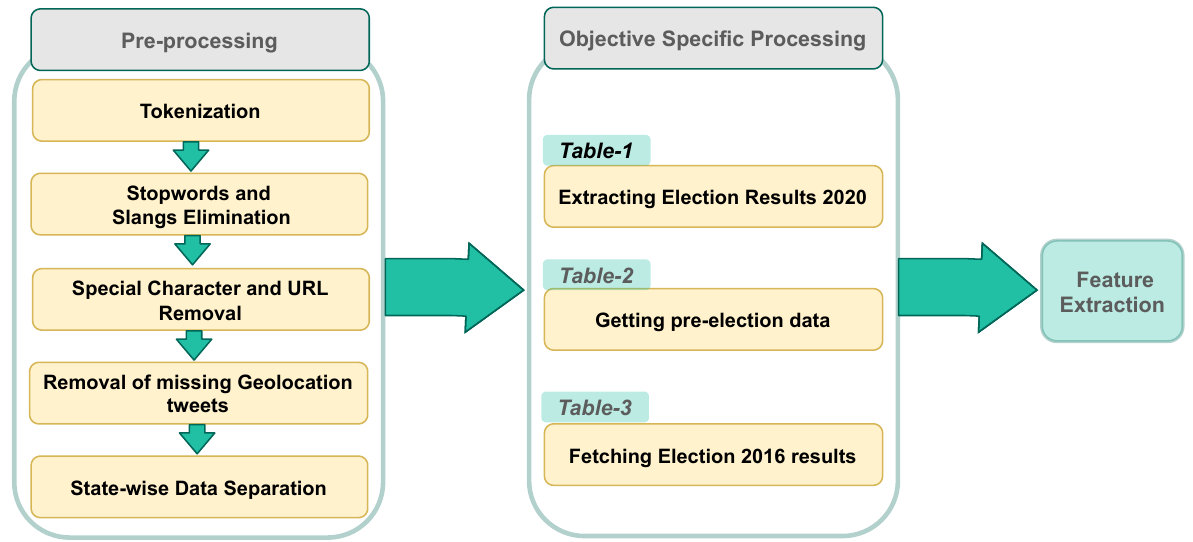
Figure 3. Detailed diagram showing pre-processing and additional result-specific